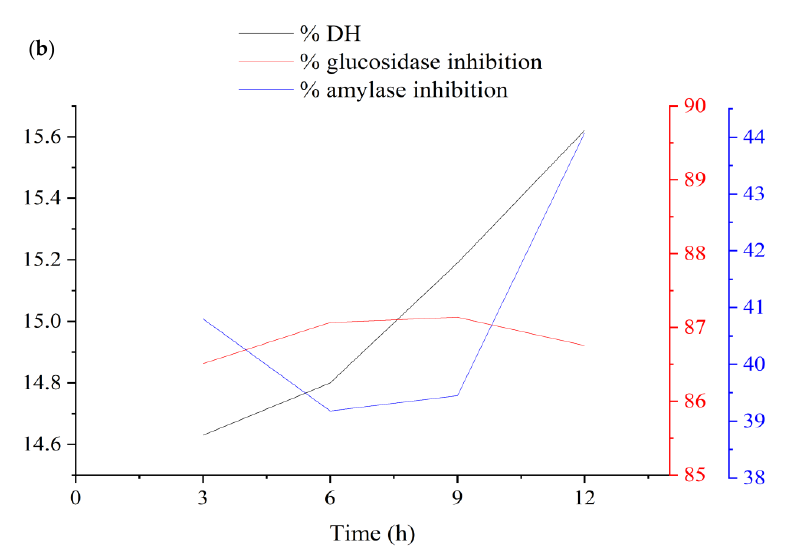
Figure 7. Effect of reaction time under optimal enzymolysis conditions on DH, α -amylase inhibition activity and α -glucosidase inhibition activity: ( a ) Using alcalase and ( b ) using trypsin. The predicted values indicated above didn’t differ significantly from the predicted values for the DH (20.48% and 14.02%), α -amylase inhibition (55.02% and 42.15%), and α -glucosidase inhibition (84.68% and 84.54%), respectively, where RSE (%) is not high and didn’t exceed 5% in most values of both hydrolysates as shown in Table 4. Table 4. Actual and predicted values observed during validation experiments under optimal con- ditions.